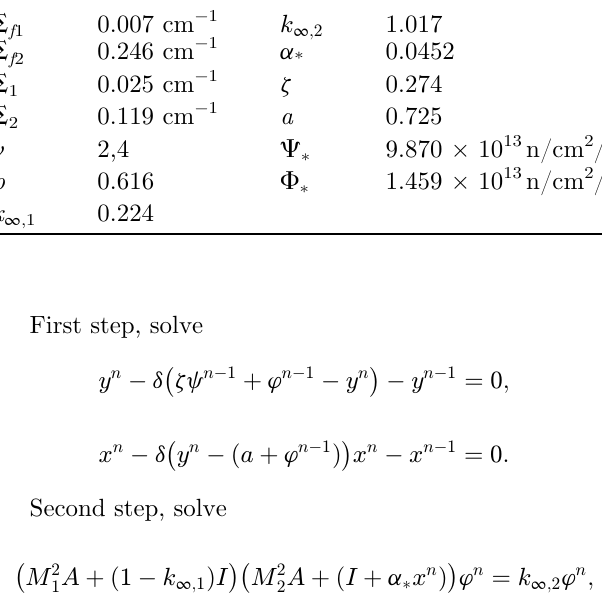
¼ 5 5 cm 2 ; M 2 ¼ 9 cm 2 1 2